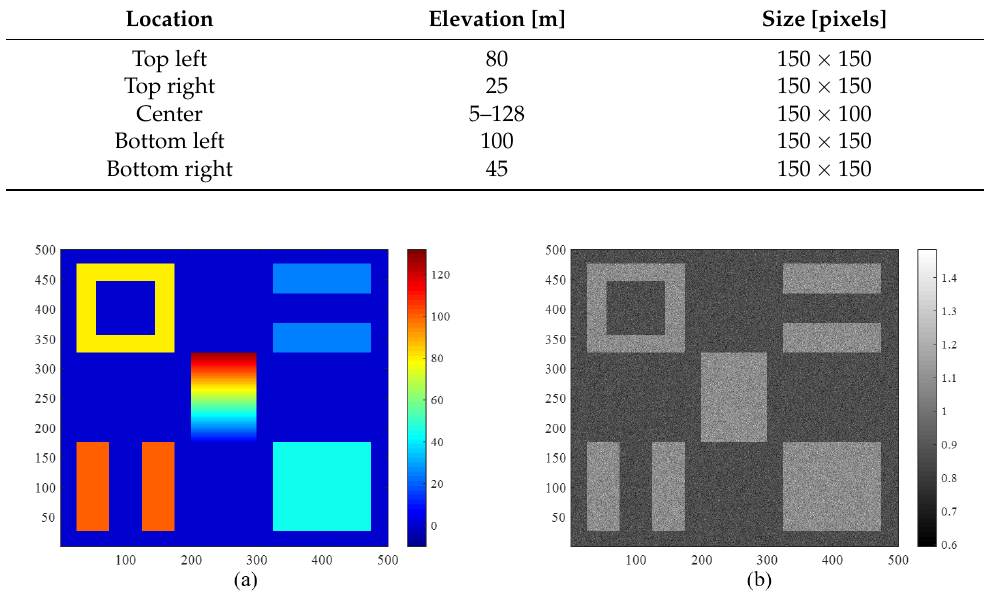
Figure 3. Simulated data with SNR = 5 dB: ( a ) the true elevation and ( b ) the mean